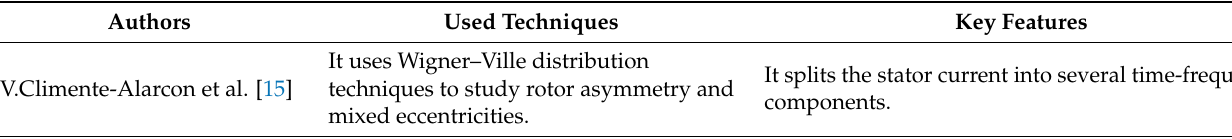
Table 2. Key features of the proposed and state-of-the-art